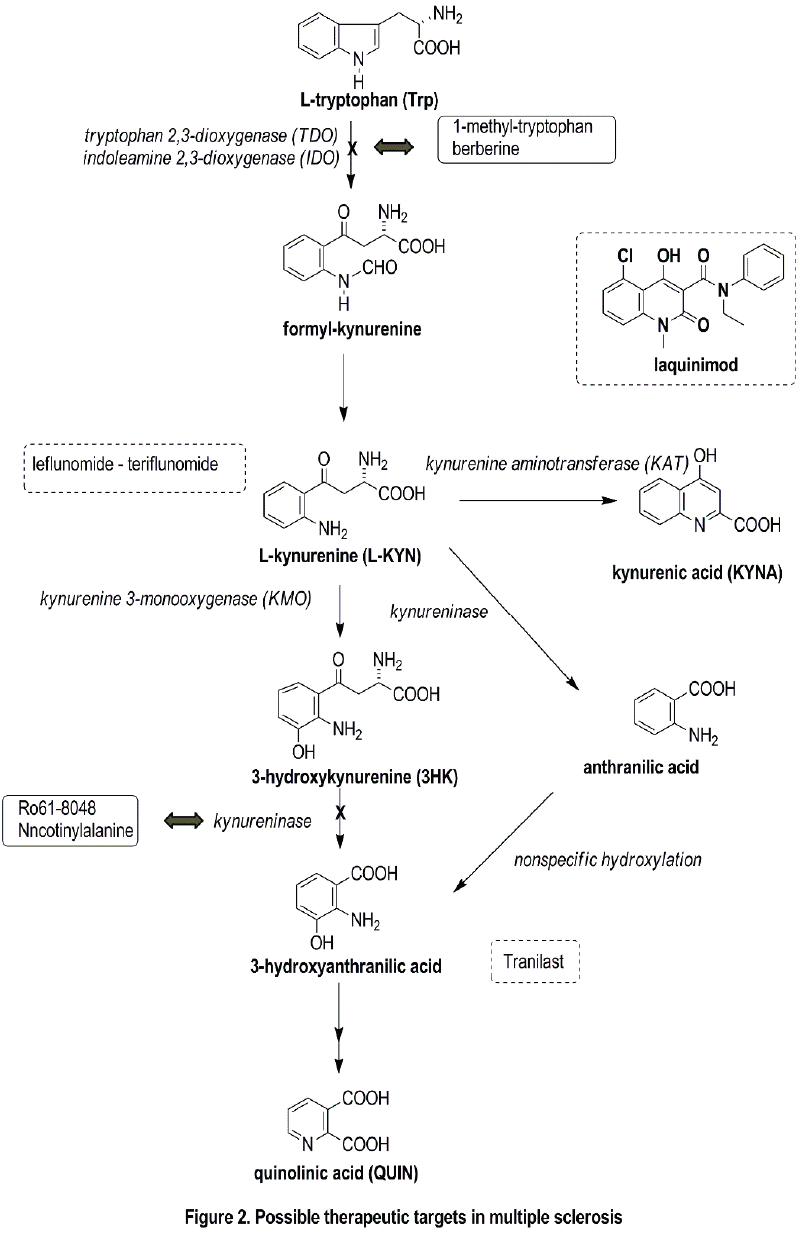
Figure 2. Possible therapeutic targets in MS. Possible therapeutic targets in the kynurenine pathway—the figure displays the future drug candidates which are influencing the kynurenine pathway (molecules indicated in the frames) or have structural similarities (represented in dashed line boxes) with kynurenine